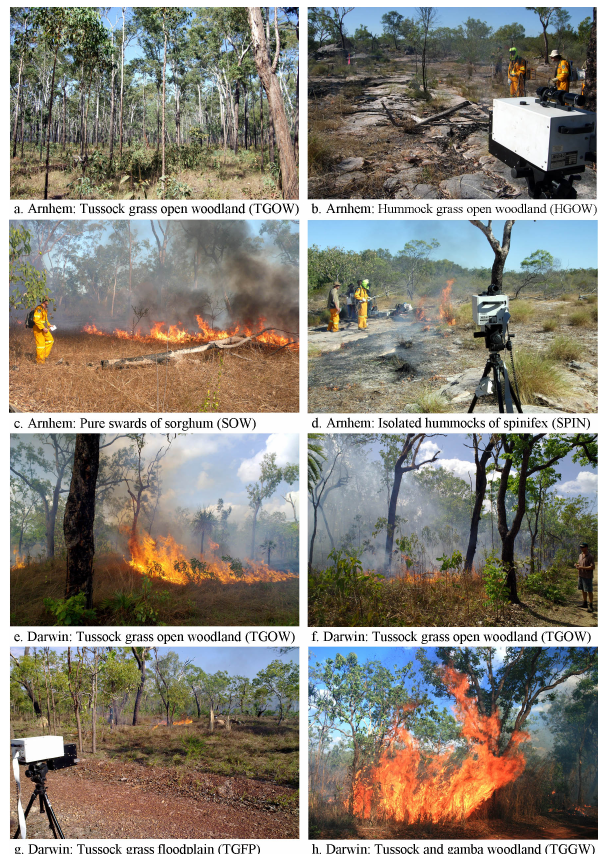
Figure 5. Photographs depicting the various savanna fire classes experienced during both the Arnhem Land (Arnhem) and Darwin region (Darwin) campaigns. The abbreviations in parentheses are used throughout this paper, more details about specific fire plots are given in Table